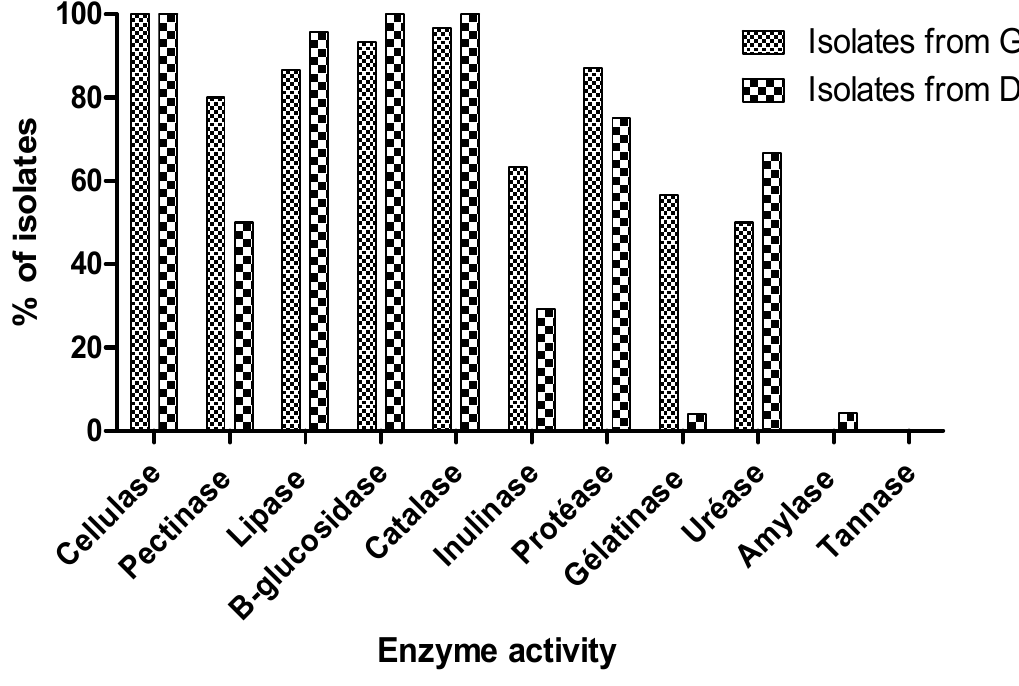
Figure 2. Qualitative tests of enzymatic activities of yeasts isolated from GGS and DR. Table 4. Enzymatic activity of isolated yeast a: Isolates from GGS, b: Isolates from DR, 1: